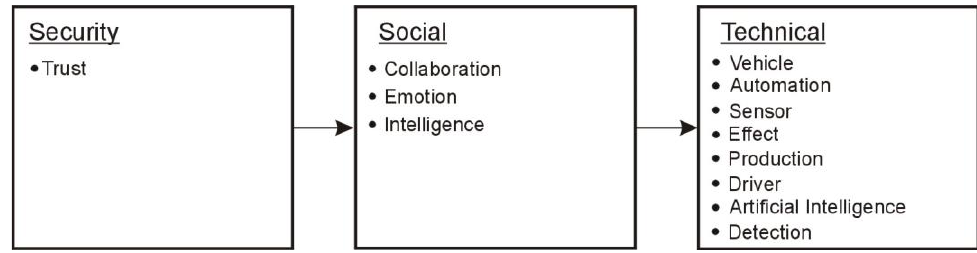
Figure 22. Human – machine relation roadmap. Figure 22. Human–machine relation